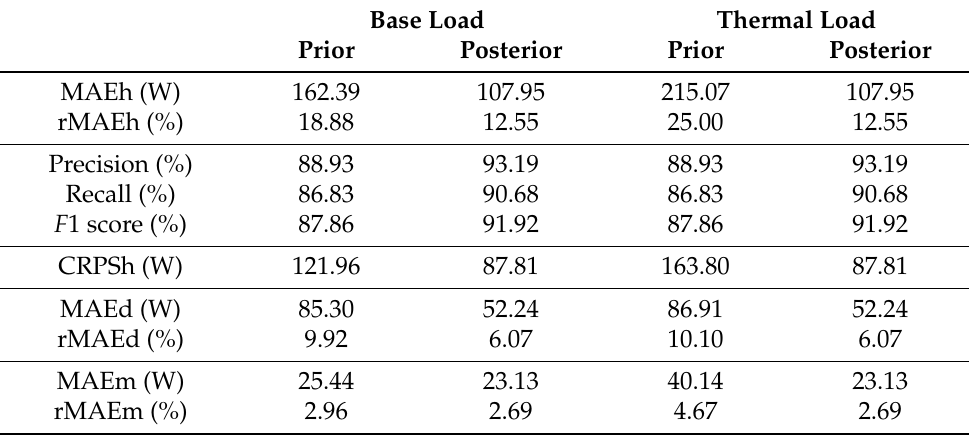
Table 1. Disaggregation accuracy results for the AMPds